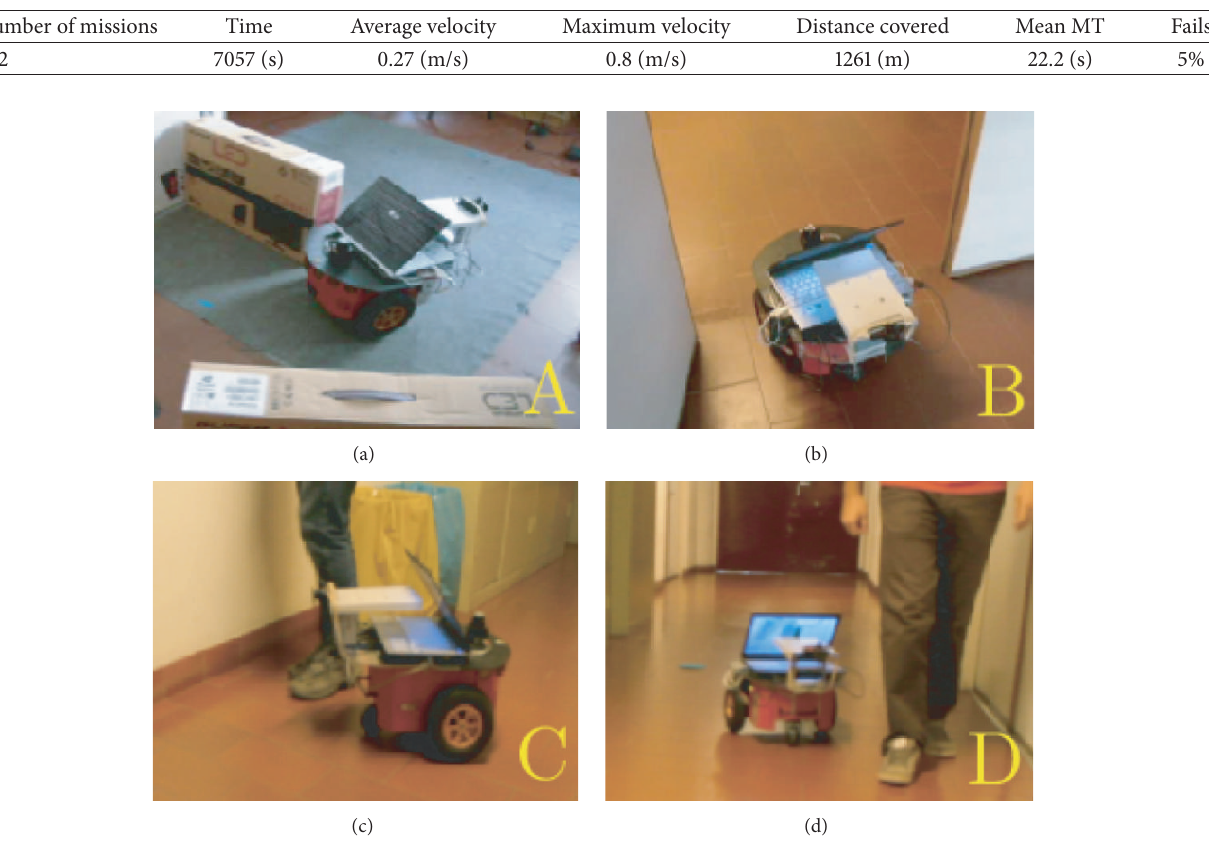
Figure 13: Snapshots of the robot performing the mission of experiment 2.